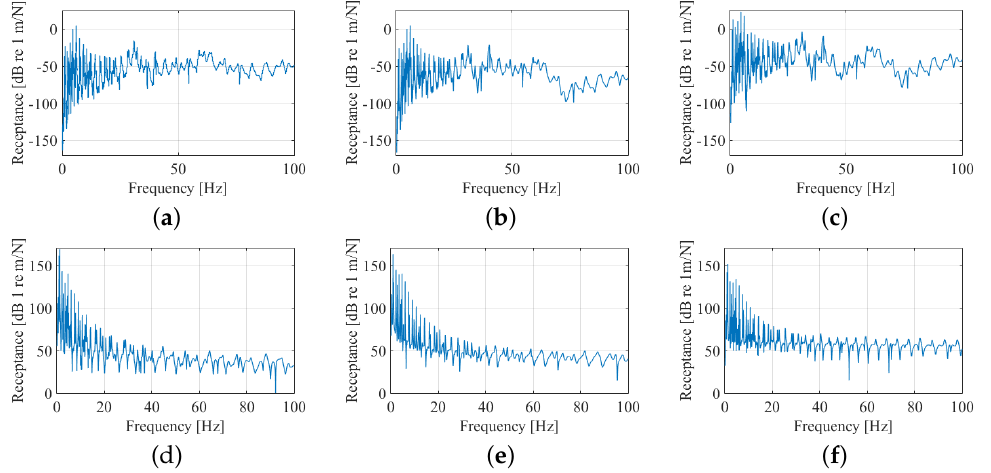
Figure 19. OTL receptances obtained by applying a distributed wind-rain load over the cable and estimating at, ( a , b ) tower; ( c ) connection point, ( d ) cable 1 m from support; ( e ) cable middle length, and ( f ) cable